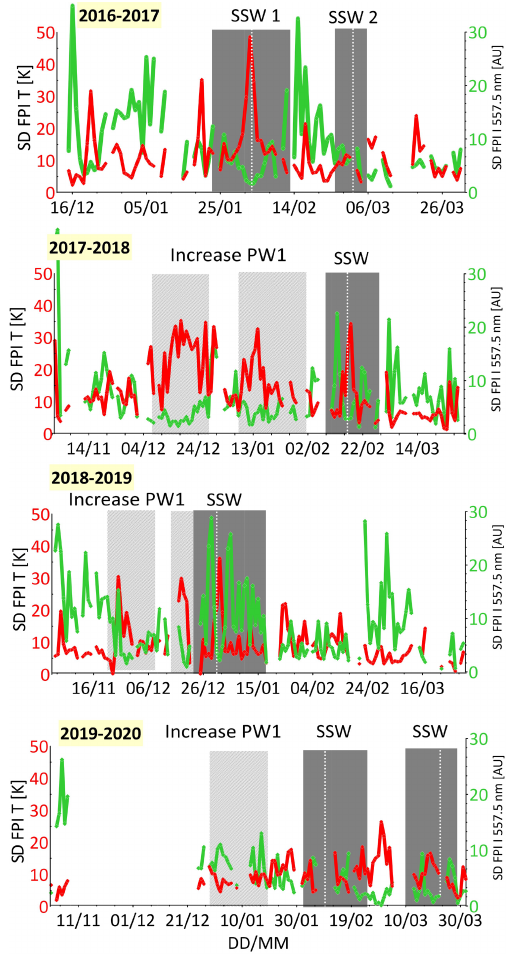
Figure 18. FPI-measured standard deviation of zonal wind, the pe- riod of the PW1 amplitude increase (light grey rectangle), the SSW periods (grey rectangle), and the day of the SSW maximal temper- ature (dotted white vertical